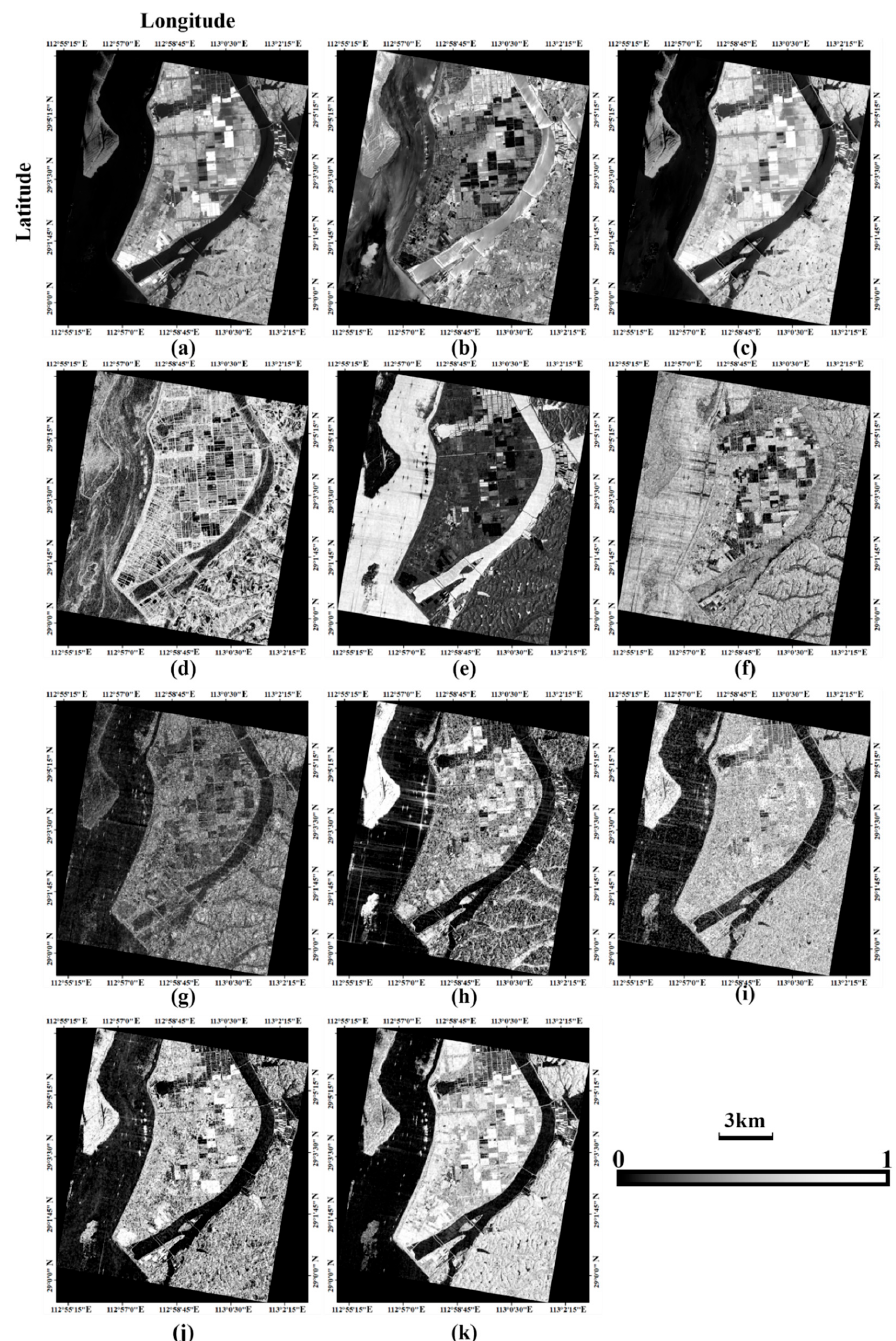
Figure 5. The features normalized to the range of [0,1]. ( a – d ) Opband pca1 , Opband pca2 , NDVI and the information entropy H extracted from the Sentinel-2A data; ( e – k ) σ pca1 , σ pca2 , RVI, P s , P d , P h and P v extracted from the GF-3 PolSAR data.